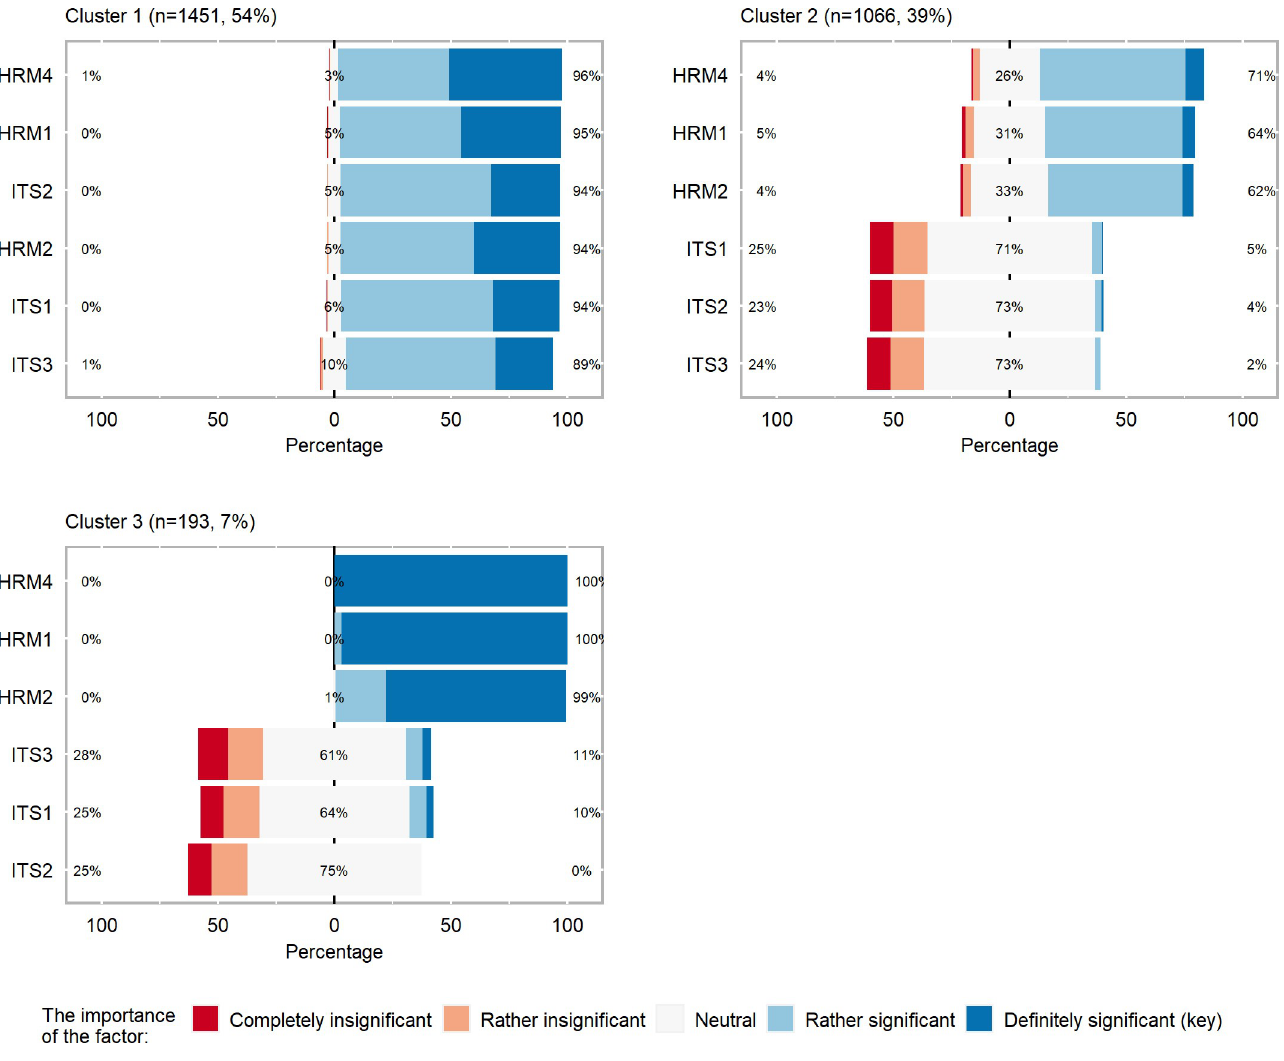
Fig 2. Distribution of management practices in each